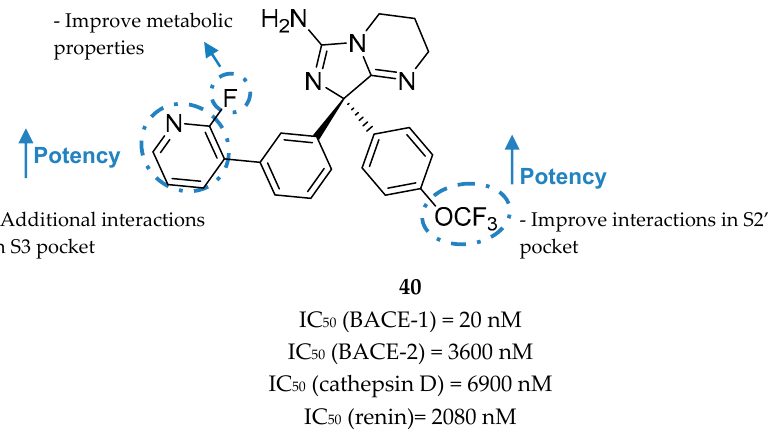
Figure 32. Optimized aminoimidazole-based inhibitor 40 from Wyeth.